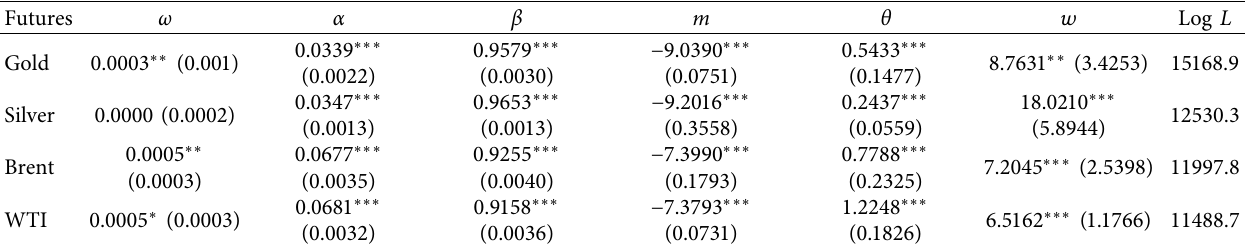
Table 5: Estimation results of GARCH-MIDAS +ID-EMV models of futures volatility by infectious disease with 12-month lags. Futures ω